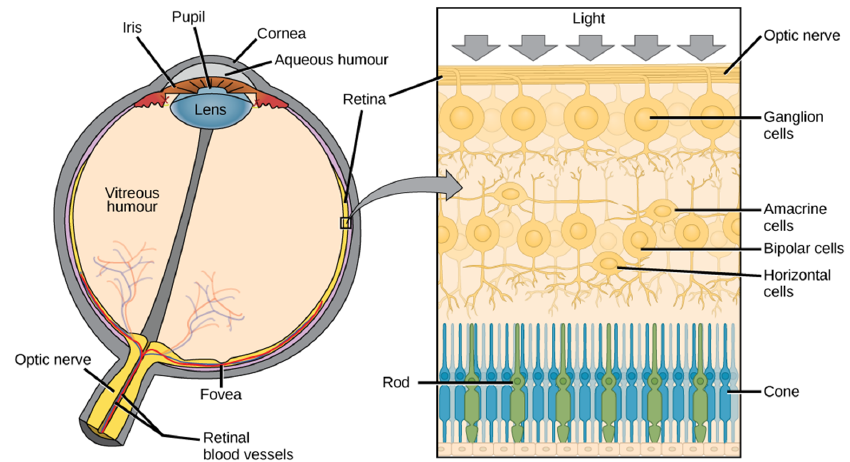
Figure 1. Anatomy of eye and retina. The different components and structures of the eye with the detail (in the right panel) of the composition of the retina. Table 1. Some drugs currently used in major ocular diseases.